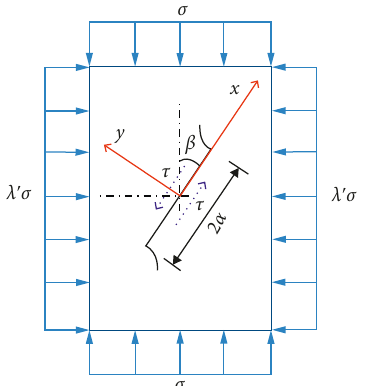
Figure 10: Oblique crack in the center of biaxial compressive